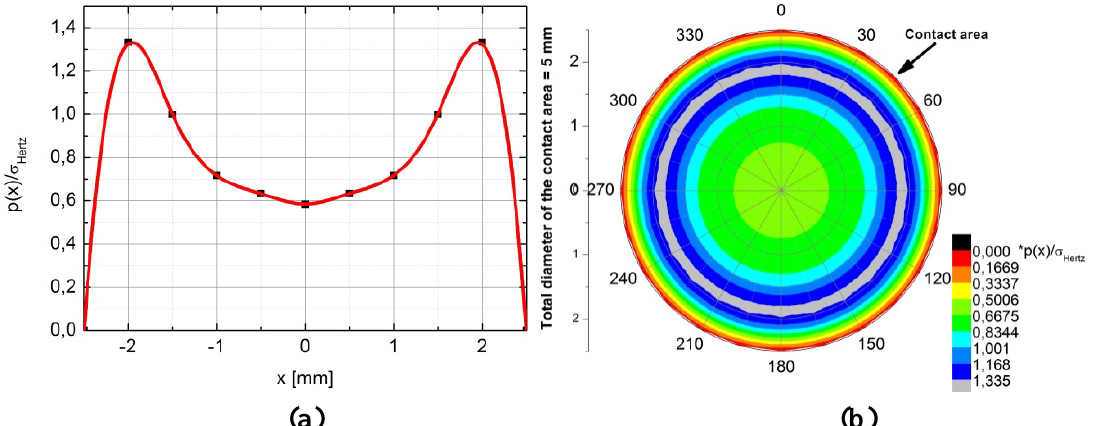
Figure 3. Distribution of the un-dimensional calculated parameter p ( x )/ σ diameter of the contact area and ( b ) across the whole contact